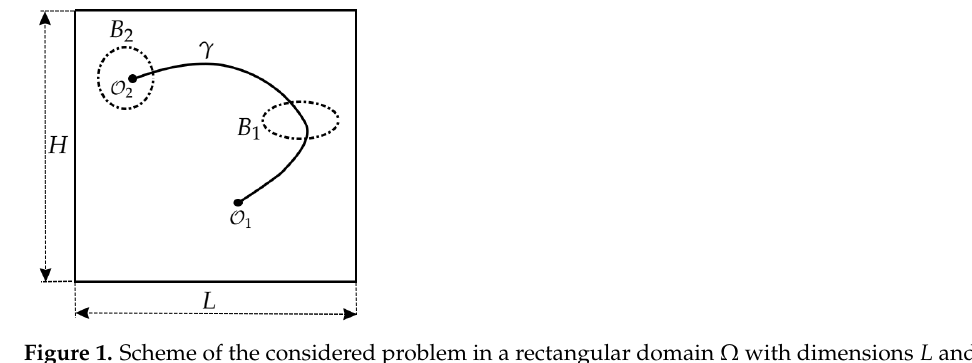
Figure 1. Scheme of the considered problem in a rectangular domain Ω with dimensions L and H . The trajectory γ with initial and final points O 1 , O 1 , respectively, follows a path connecting the sets B 1 and B 2 where an initial mosquito population density is